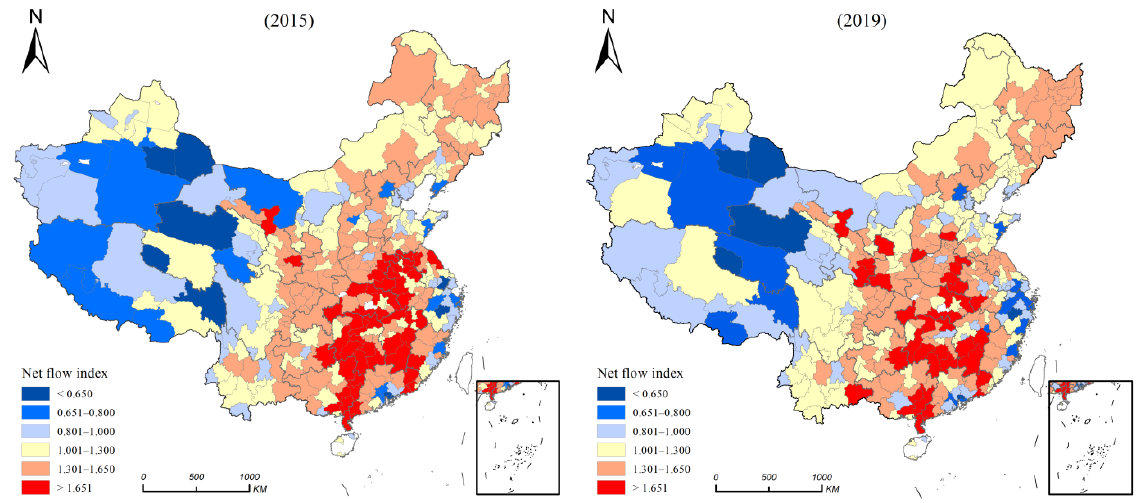
Figure 3. Spatial distribution of net population flow during Spring Festival Transport in China.